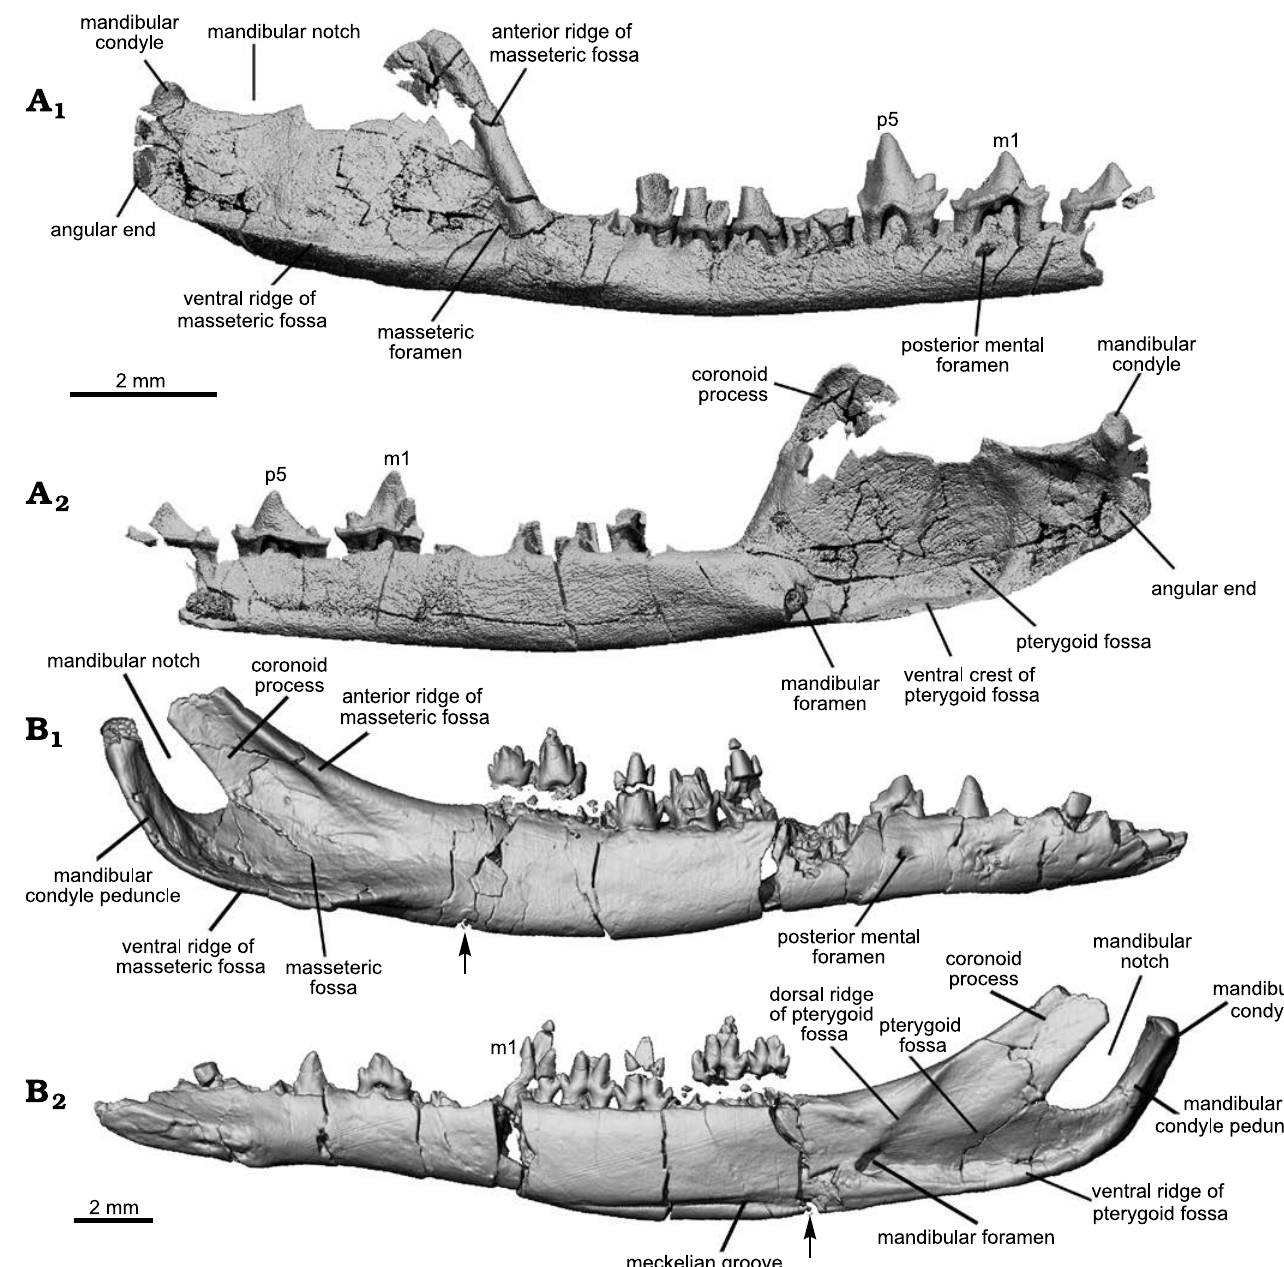
Fig 6. Comparison of the mandibular morphologies of Origolestes and Lactodens . A . Lactodens sheni Han and Meng, 2016 (holotype, HG-M016) from Aptian, Lower Cretaceous Jiufotang Formation of Shangheshou area, Caoyang City, Liaoning Province, China; posterior portion of the right mandible in buccal (A 1 ) and lingual (A 2 ) views. B . Origolestes lii Mao, Hu, Li, Wang, Chase, Smith, and Meng, 2020 (IVPP V13604) from Lower Cretaceous Lujiatun beds of the Yixian Formation of the Lujiatun locality, Beipiao County, Liaoning Province, China; right mandible in buccal (B 1 ) and lingual (B 2 ) views. The mandible in B was slightly displaced at the crack (marked with the arrow) and has been digitally restored (see Mao et al.